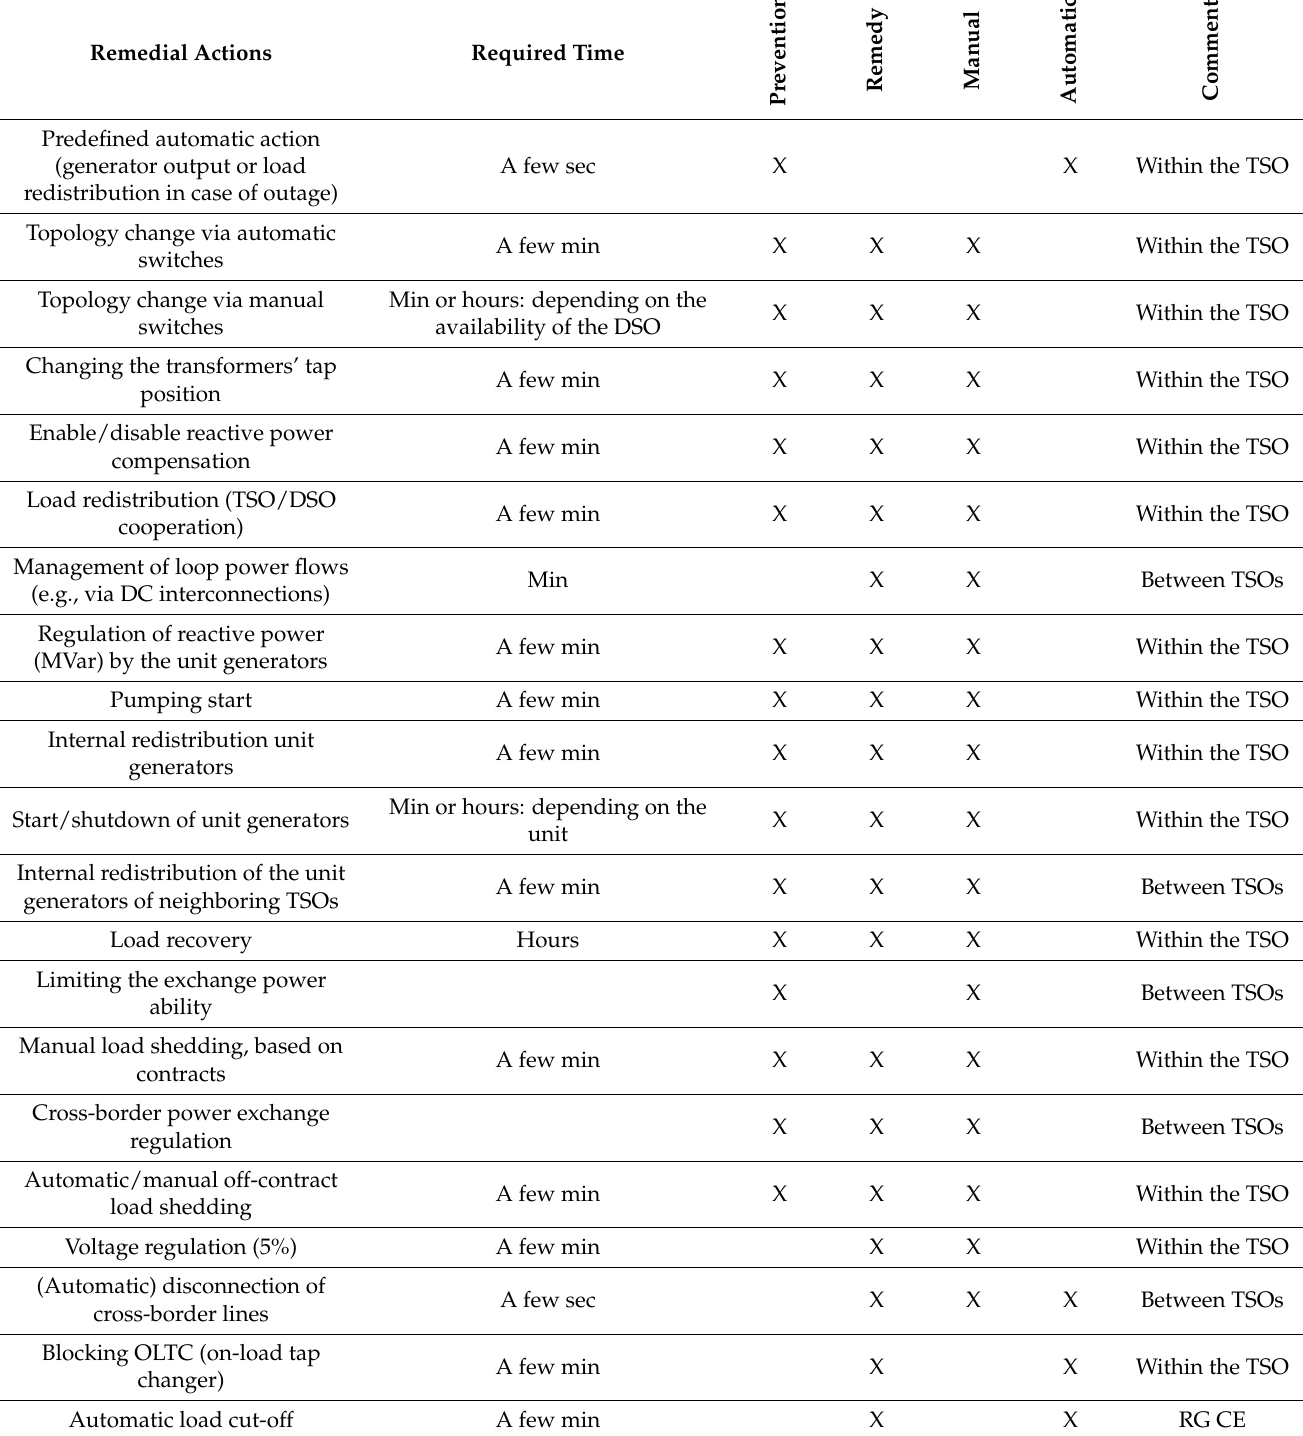
Table 3. Remedial actions for the power system in an